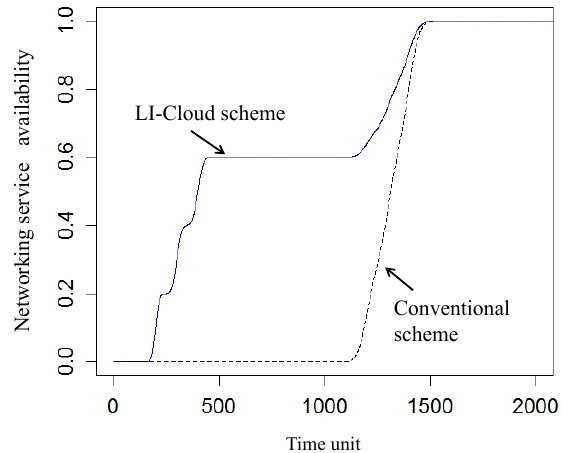
Figure 5. I-NSA for users in the scenario of parallel deployment of networking services with (Possion distribution of restoration. Ta, Tb, and Tc are set to 200, 300, and 400, and T AG , T BG , and T CG are set to 1200, 1300, and 1400,